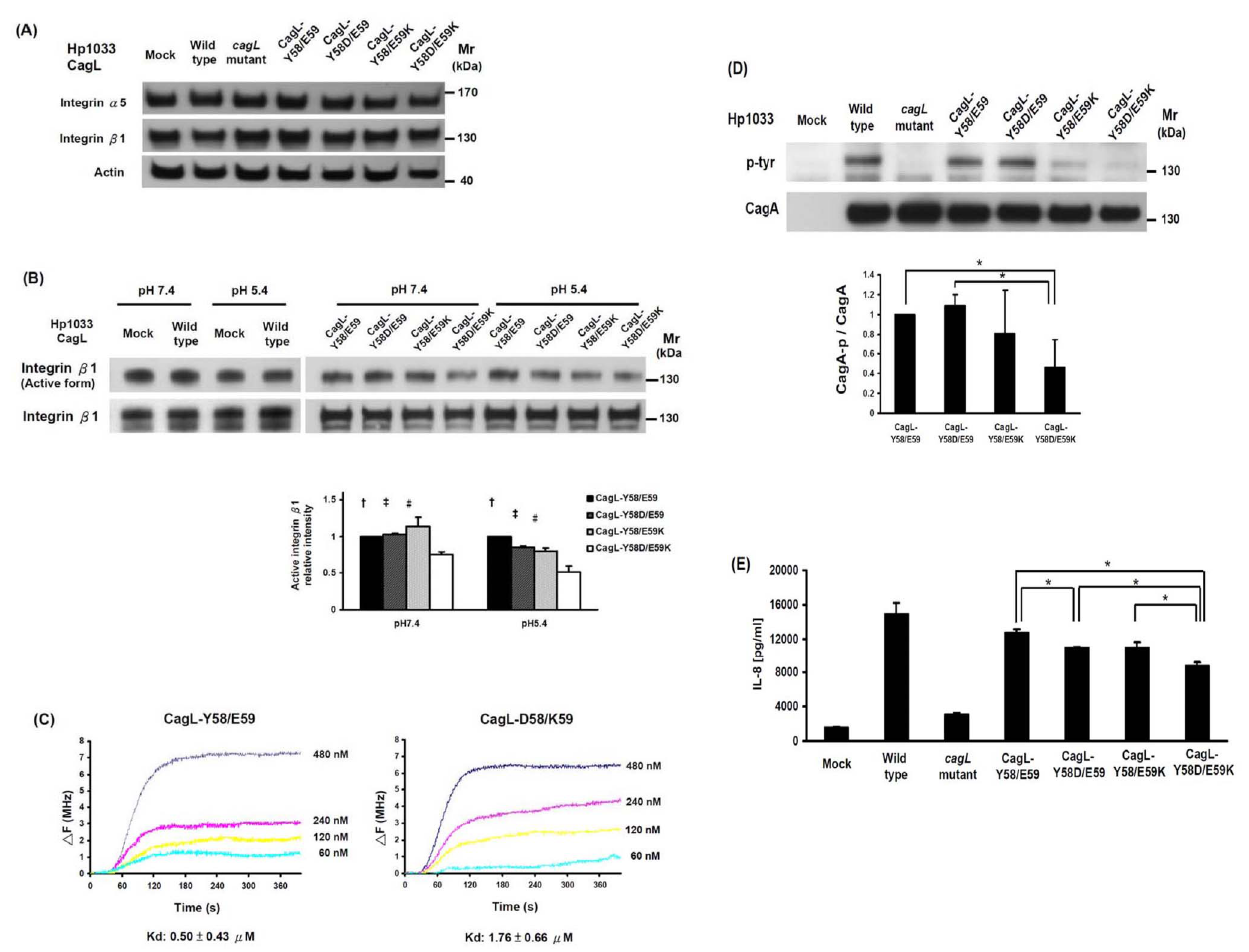
Figure 2. H.pylori CagL-Y58/E59 triggered higher integrin b 1 activation, CagA translocation and IL-8 secretion of AGS cells than CagL-Y58D/E59K did. ( A ) Integrin a 5 and b 1 expressions of AGS cells cultivated alone or co-cultivated with 4 wild-type Hp1033 cagL isogenic mutants (CagL-Y58/E59 revertant, Y58D/E59, Y58/E59K, and Y58D/E59K amino acid replacement mutants) at pH 5.4 for 18 hours were analyzed by immunoblotting. There was no difference in the integrin a 5 and b 1 expressions among these 4 H. pylori isolates. ( B ) The active form integrin b 1 of AGS cells co-cultivated with CagL amino acid replacement mutants at pH 7.4 and 5.4 were analyzed by immunoblotting. The values of the active forms of integrin b 1 were normalized to total forms, and there were significant higher in CagL-Y58/E59 than in CagL-Y58D/E59K at pH 7.4, higher in CagL-Y58/E59 than other mutants at pH 5.4 ( { p , 0.05), higher in CagL-Y58D/E59 than in CagL-Y58D/E59K at both pH 7.4 and pH 5.4 ( ` p , 0.05), and higher in CagL-Y58/E59K than in CagL-Y58D/E59K at pH 7.4 and pH 5.4 ( # p , 0.05). ( C ) Quartz crystal microbalance measurement of the interaction of CagL-Y58/E59 and CagL-D58/K59 with immobilized integrin a 5 b 1. g F is the change of frequency (MHz) after different CagL proteins in range of 60 to 480 nM binding to integrin. The kd translated from g F via software (Affinity Evaluation Software v1.0, ANT technology Co., Ltd). The Kd was lower in CagL-Y58/E59 than in CagL-D58/K59, indicating the stronger binding affinity of the former. ( D ) The ability of CagA translocation was represented by CagA phosphorylation (p-CagA) levels in AGS cells co-cultivated with CagL-Y58/E59 revertant, Y58D/E59, Y58/E59K, and Y58D/E59K amino acid replacement mutants at pH 5.4 for 1 h. The value of p-CagA, normalized to CagA, was lower in the CagL-Y58D/E59K than in either CagL-Y58/E59 or CagL-Y58D/E59, (* p , 0.05). The data were mean 6 standard deviations of the triplicate experiments. ( E ) There were significant differences of IL-8 levels triggered between CagL-Y58/E59 vs . CagL-Y58D/E59, CagL-Y58/E59 vs . CagL-Y58D/E59K, CagL-Y58D/E59 vs . CagL-Y58D/E59K, and CagL-Y58/ E59K vs . CagL-Y58D/E59K isolates ( p , 0.05). integrin b 1 activation than H. pylori CagL-Y58D/E59K did cancers. These findings are particularly important to indicate that ( p , 0.05), it did not do so for integrin expression ( p . 0.05, integrin a 5 b 1 activation and expression primed by H. pylori CagL amino acid polymorphisms exist in a hypochlorhydria vicious Figure 2A ). This suggests that integrin a 5 b 1 expression might not be primed by H. pylori directly, and that some cytokines released cycle that promotes gastric carcinogenesis. from activated immune cells may be possibly involved to up- Integrin a 5 b 1 is a receptor of gastric epithelial cells for H. pylori regulate integrin a 5 b 1 expression [27,28]. It is thus worth further binding, which increases the risk of gastric cancer [3,8,9]. Because study to determine whether H. pylori CagL-Y58/E59 attracts H. pylori CagL-Y58/E59 has a 4.6-fold risk in the development of immune cells and stimulates cytokine secretion to prime integrin gastric cancers and exploits higher integrin a 5 b 1 in corpus [9], we expression in gastric epithelial cells. Integrin clustering, which tested whether such an isolate exerted a unique priming on gastric drives integrin b 1 activation [29], is a vitally necessary step for integrin a 5 b 1 expression or activation. It can be observed in CagA translocation [30]. Given that H. pylori carrying the CagL- Figure 2B that while H. pylori CagL-Y58/E59 triggered higher